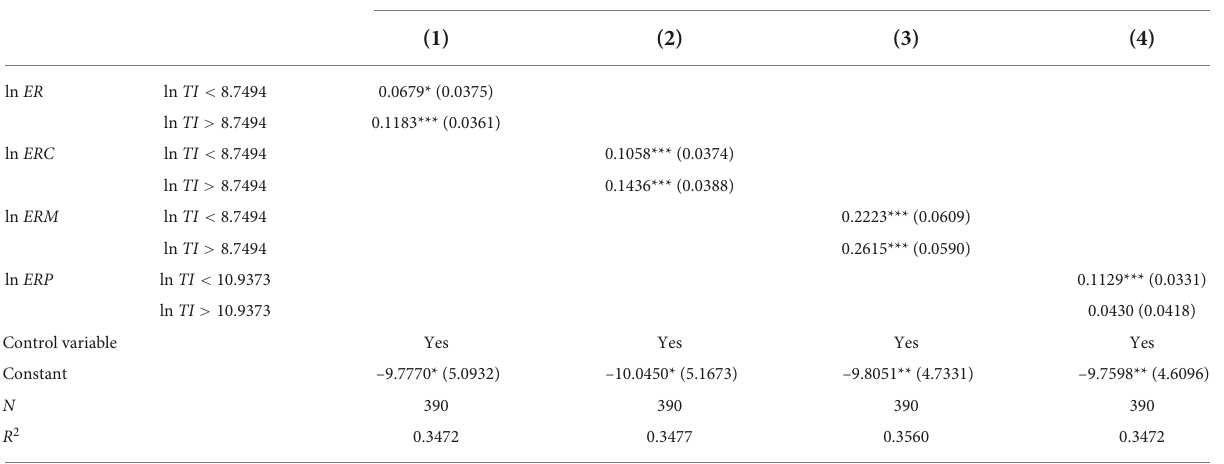
TABLE 6 Regression results of the technological progress threshold model.